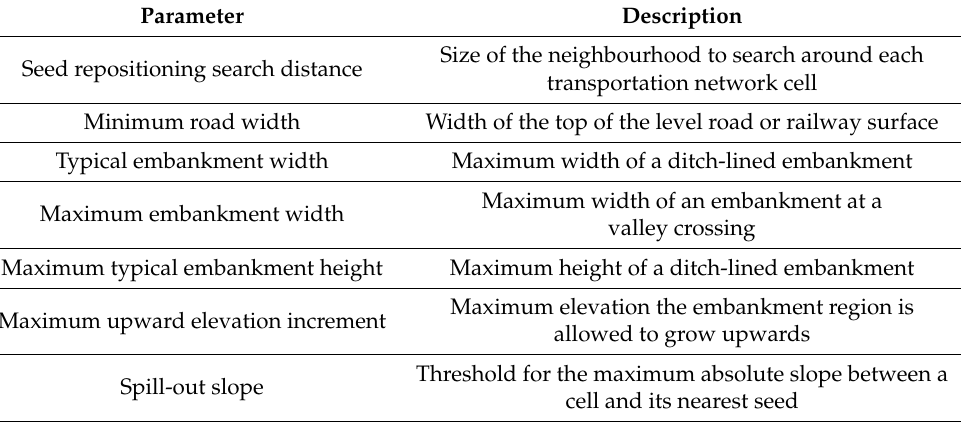
Table 1. User-defined parameters required by the embankment mapping tool. All parameters are specified in map units, except for spill-out slope which is specified in